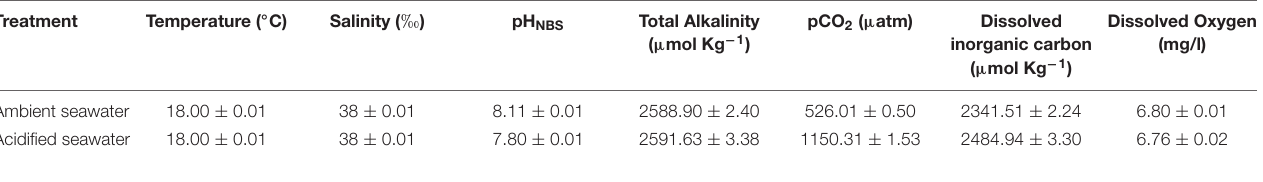
TABLE 1 | Seawater chemical parameters expressed as means ± SD.